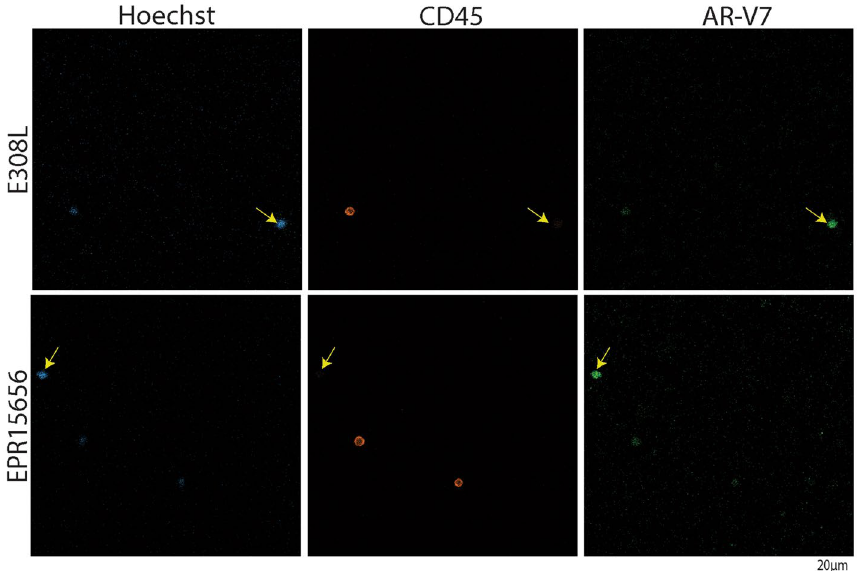
Figure 4. AR-V7 CTC detection. CTCs were identified based on AR-V7 staining. In brief, nucleated (blue, Hoechst) events were included in CTC counts if negative for CD45 (orange) and positive for AR-V7 (green) using the indicated anti-AR-V7 antibodies. AR-V7 was considered positive if intensities (Olympus cellSens Dimension image analysis software) were comparable or above intensities of cells weak but clearly identifiable (by operator) AR-V7 staining in 22RV1 (included as positive controls in each staining